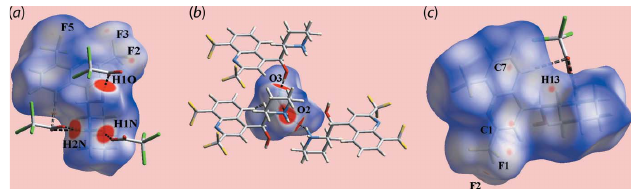
Figure 4 Views of the Hirshfeld surface of (I) mapped over d norm in the range (cid:3) 0.121 to +1.475 a.u. for the ( a ) cation, ( b ) anion and ( c ) ion pair. The N—H (cid:2)(cid:2)(cid:2) O, O—H (cid:2)(cid:2)(cid:2) O and C—H (cid:2)(cid:2)(cid:2) O contacts are shown as black dashed lines. The faint-red spots near the labelled atoms in ( b ) and ( c ) indicate the short interatomic contacts (see text and Table 2). surfaces mapped over d in Fig. 3 represent the charge- norm assisted N—H (cid:2) (cid:2) (cid:2) O hydrogen-bonds; the methylene-C13— H (cid:2) (cid:2) (cid:2) O3 contact, Table 2, on the Hirshfeld surface is evident as the diminutive-red spot between the respective atoms in Fig. 3( b ). The presence of bright- and broad-red spots near the ammonium-H1 N and H2 N , hydroxyl-H1 O , carboxylate-O2 Fig. 4( a ) and ( c ), and the Cl1 atom, Fig. 3( b ), indicate the and O3 atoms on the d -mapped Hirshfeld surfaces indi- norm cate the influence of the charge-assisted N—H (cid:2) (cid:2) (cid:2) O and O— Table 2. The effect of intermolecular C— X (cid:2) (cid:2) (cid:2) (cid:2) interactions H (cid:2) (cid:2) (cid:2) O hydrogen bonds, as indicated in Fig. 4( a ) and ( b ). The ( X = F, Cl), Table 1, is illustrated in Fig. 6 through the blue and donors and acceptors of intermolecular interactions in the orange regions near the respective donors and acceptors on crystals of (I) are also highlighted with blue and red regions the Hirshfeld surfaces mapped with shape-index properties. corresponding to positive and negative electrostatic potentials, The overall two-dimensional fingerprint plot for (I), Fig. 7, respectively, on the Hirshfeld surfaces mapped over electro- static potentials in Fig. 5. The presence of the faint-red spots contacts (McKinnon et al. , 2007) are illustrated in Fig. 7; the percentage contributions from the different interatomic contacts to the Hirshfeld surfaces are summarized in Table 3.